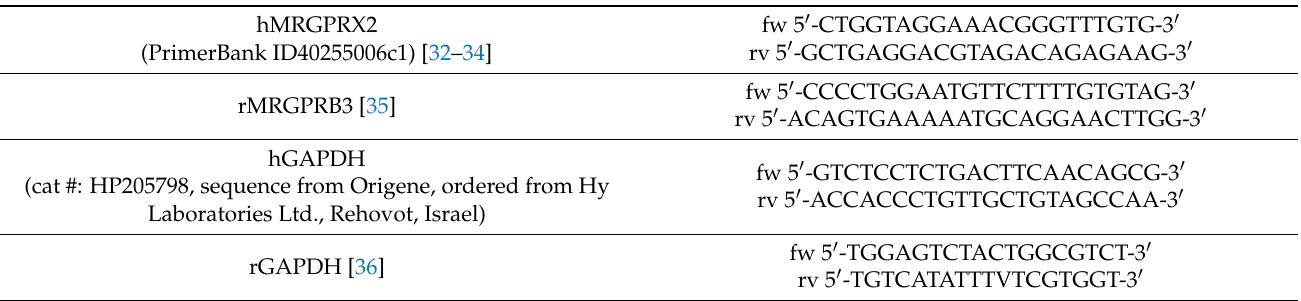
Table 2. Primers used in this